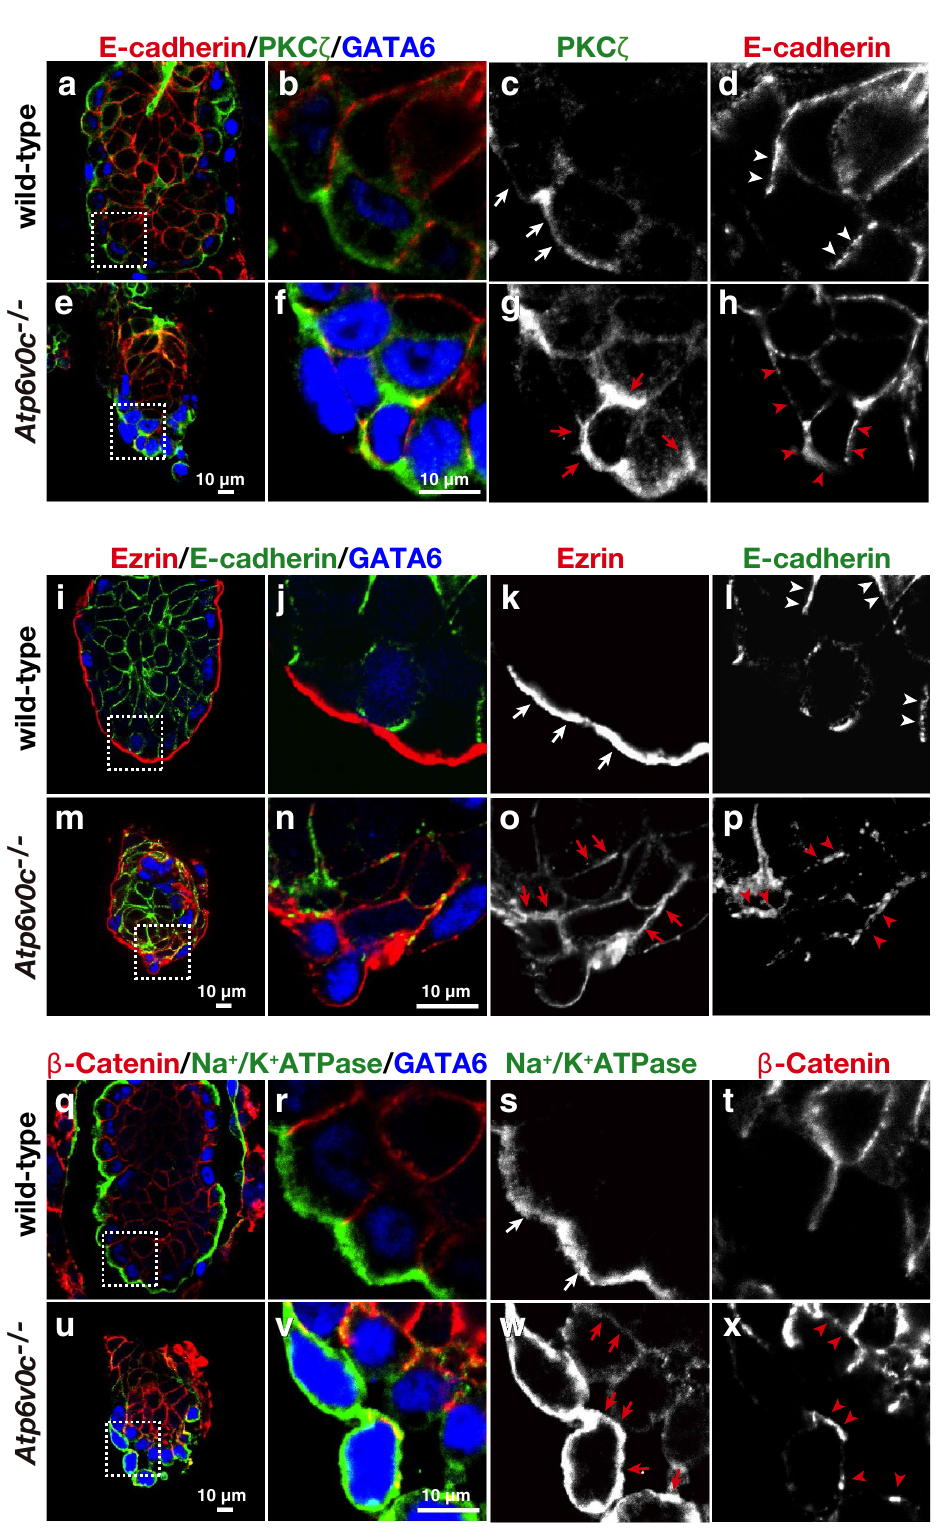
Figure 2. Immunofluorescence analyses of E5.5 embryos with apical and basolateral markers. The wild-type and Atp6v0c mutant embryos were labelled with anti-E-cadherin (red) (wild-type: n = 25, mutant: n = 6), PKCζ (green) (wild-type: n = 5, mutant: n = 4), and GATA6 (blue) antibodies ( a to h ). The embryos were labelled with anti-ezrin (red) (wild-type: n = 5, mutant: n = 3), E-cadherin (green), and GATA6 (blue) antibodies ( i to p ). The embryos were also treated with anti-β-catenin (red) (wild-type: n = 6, mutant: n = 4), Na + /K + -ATPase (green) (wild-type: n = 3, mutant: n = 4), and GATA6 (blue) antibodies ( q to x ). The apical markers and basolateral markers in wild-type embryos are indicated by white arrows and arrowheads, respectively. The signals of apical markers and basolateral markers in mutant embryos are indicated by red arrows and arrowheads, respectively. Scale bar, 10